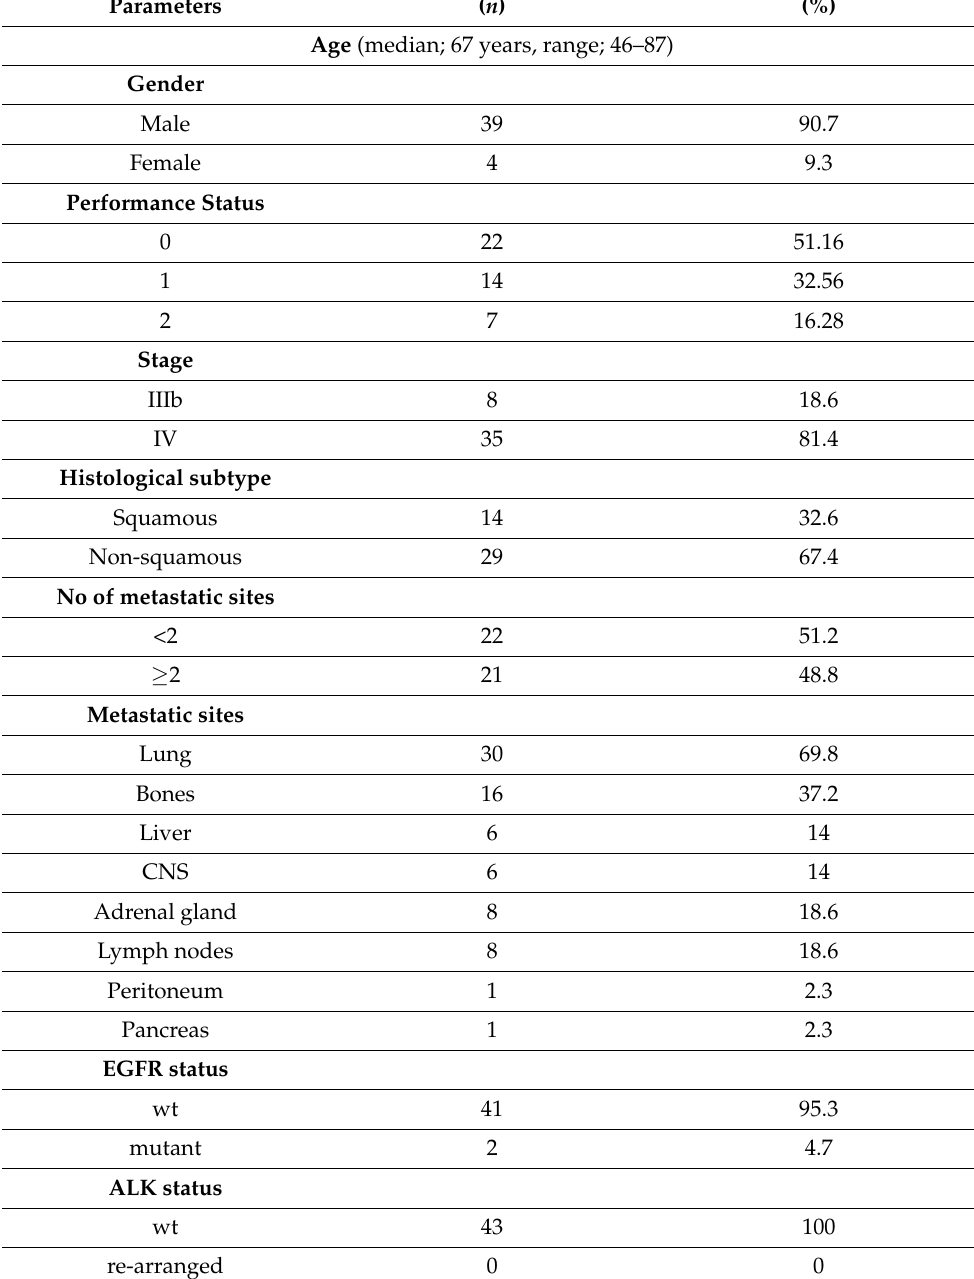
Table 1. Patient and Disease Characteristics (No of patients: n =